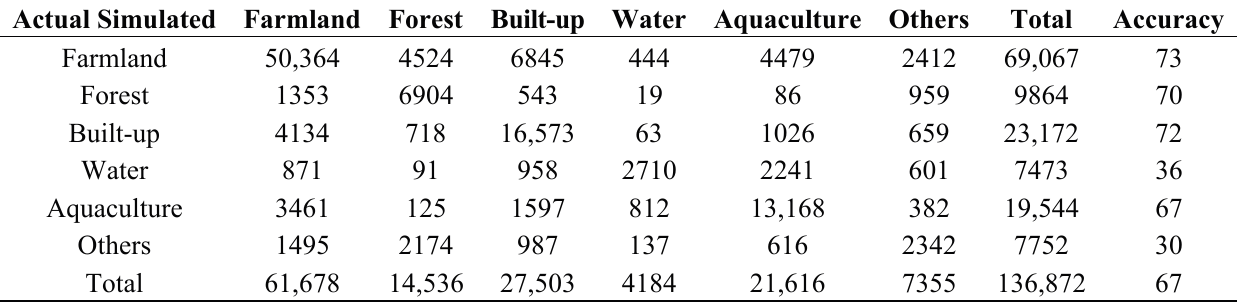
Table A3. Results of Model Accuracy (Area Units: Hectares; Accuracy Units: %). Actual